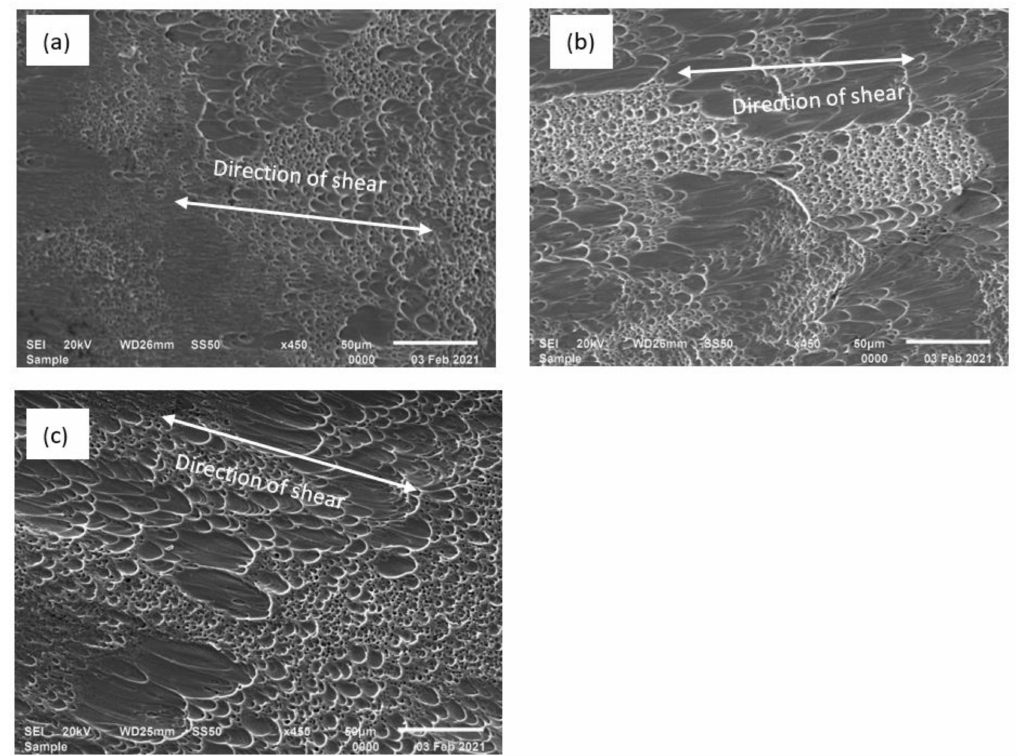
Figure 22. Typical characteristic features on the fracture surfaces of samples E at temperatures of ( a ) 25 ◦ C, ( b ) 200 ◦ C, and ( c ) 500 ◦ C at a magnification of X450.